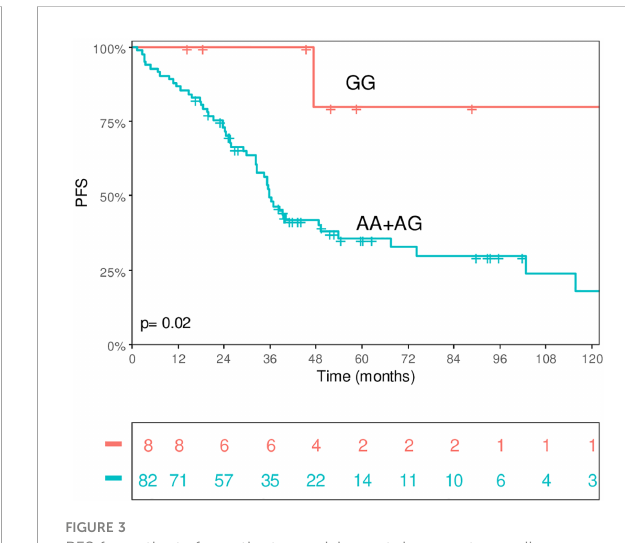
FIGURE 3 PFS for patients for patients receiving autologous stem cell transplant according to CTLA4 rs2311775